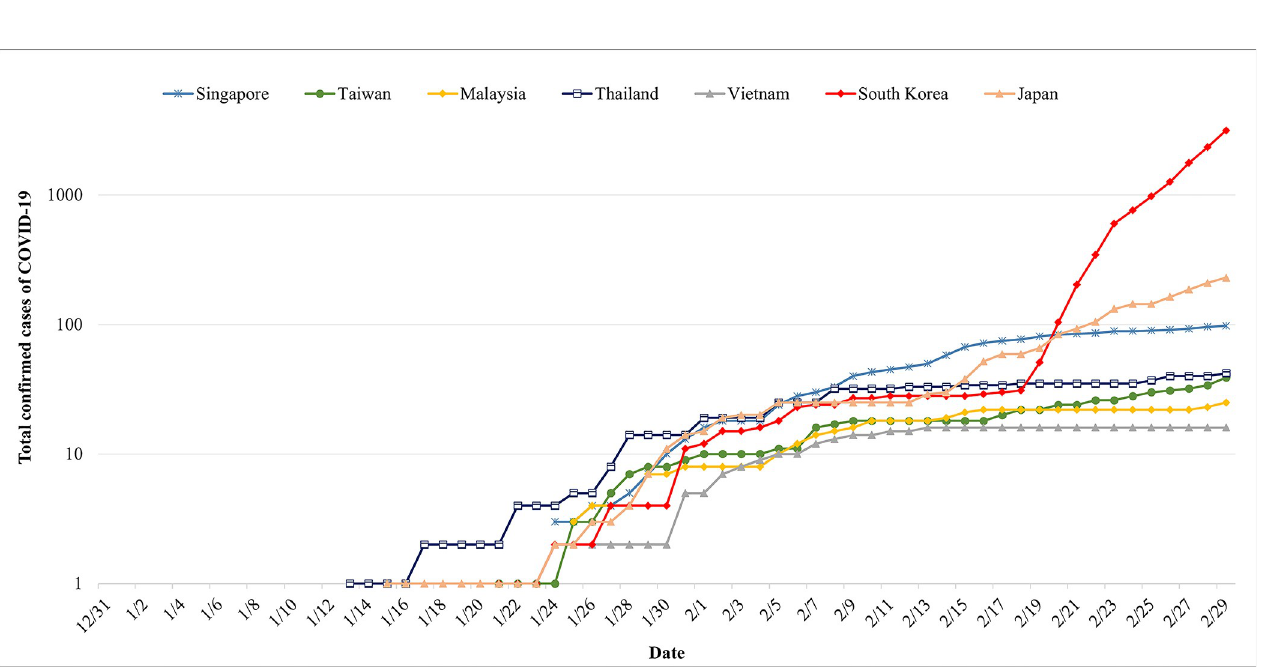
Fig 4. Trends of total confirmed cases of COVID-19 in Taiwan, Singapore, Malaysia, Thailand, Vietnam, South Korea, and Japan.